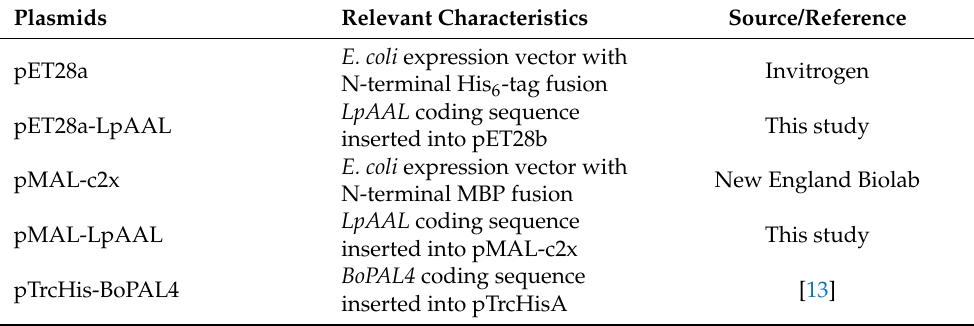
E. coli expression vector with N-terminal His 6 -tag fusion LpAAL coding sequence inserted into pET28b E. coli expression vector with N-terminal MBP fusion LpAAL coding sequence